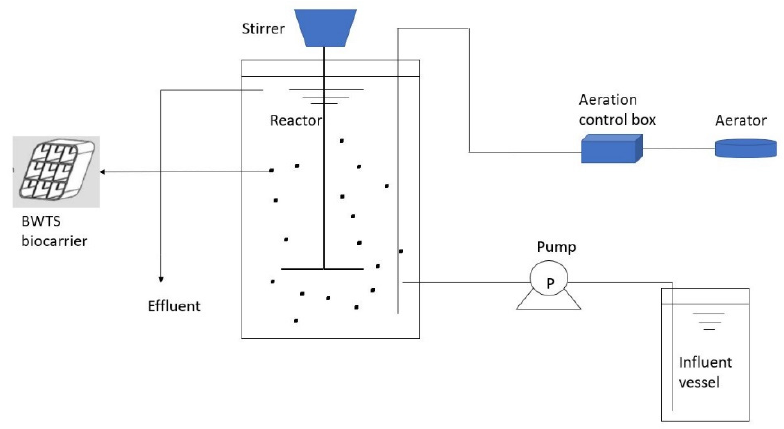
Figure 3. A schematic diagram of the experimental setup of MBBR reactor.